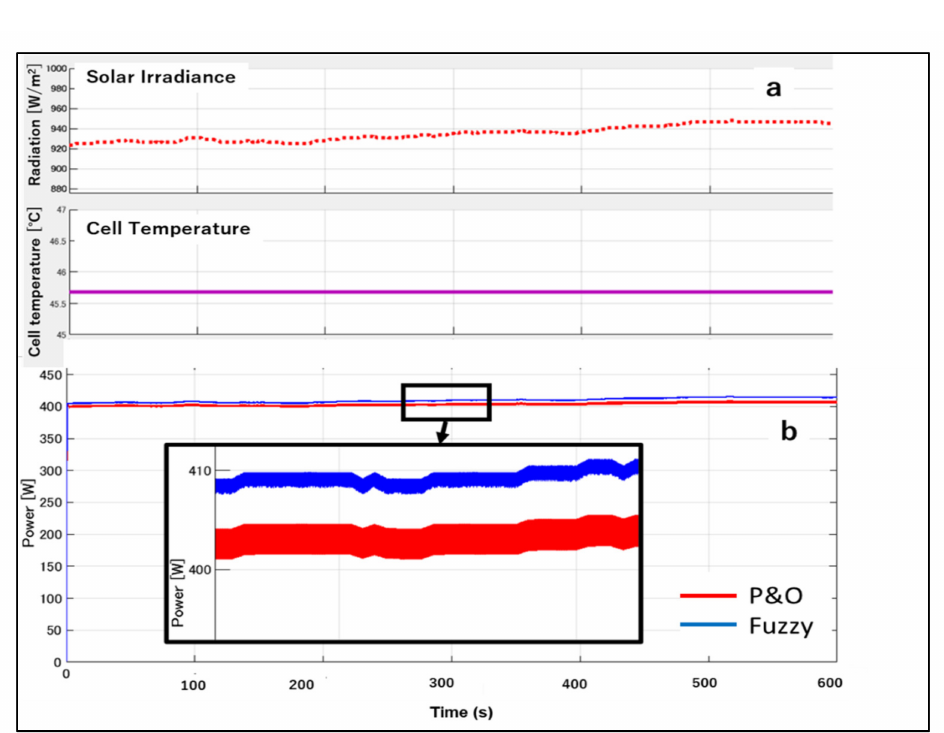
Figure 18. Comparison between the FLC-based and perturbation and observation (P&O)-based MPPT systems for PV (sunn day): ( a ) Weather conditions; ( b ) Output